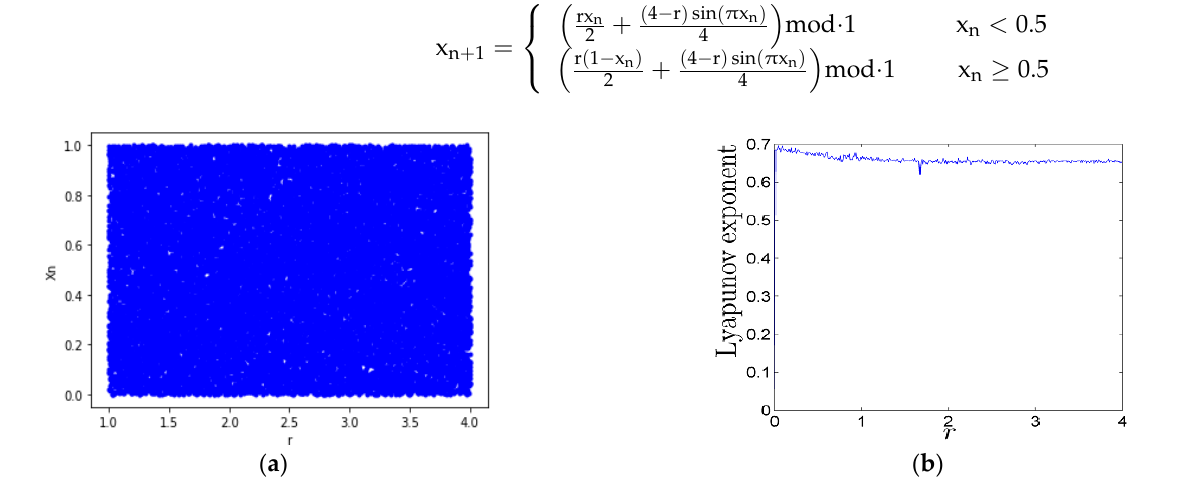
Figure 6. Dynamical behavior of TSS: ( a ) bifurcation plot; ( b ) Lyapunov exponent.